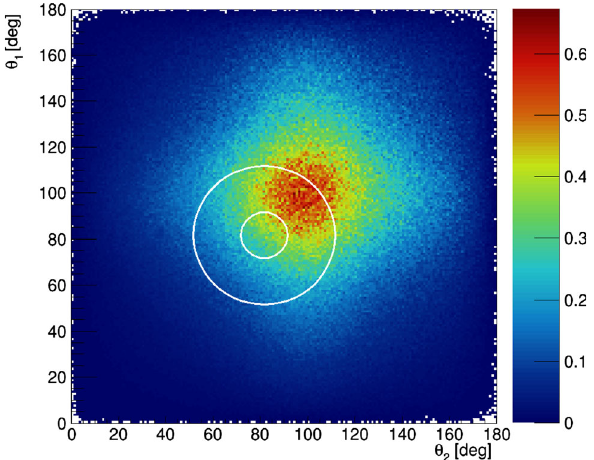
Fig. 12 Idealized(notincludingeventselectioncriteria)detectioneffi- ciencyoftheJ-PETdetectorasafunctionof θ 1 vs θ 2 .Thesuperimposed circles indicate regions with radius of R = 10 ◦ and R = 30 ◦ around the point of the highest visibility θ 1 = θ 2 = 81 . 66 ◦